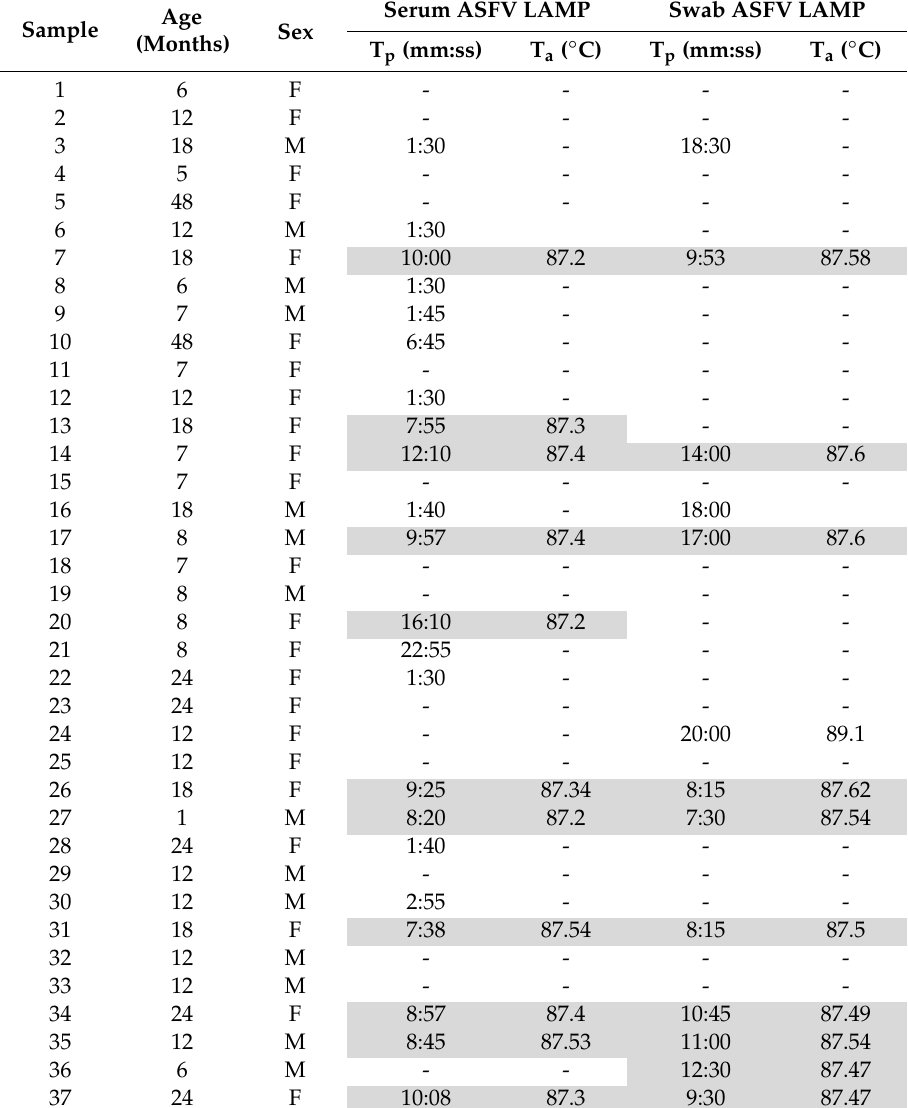
Table 6. Results of 37 serum and matching oral / rectal swabs tested with the ASFV LAMP. Grey highlighting indicates a positive for that particular